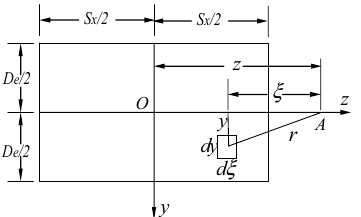
Figure 11. Analytical diagram of the compression area of the anchor